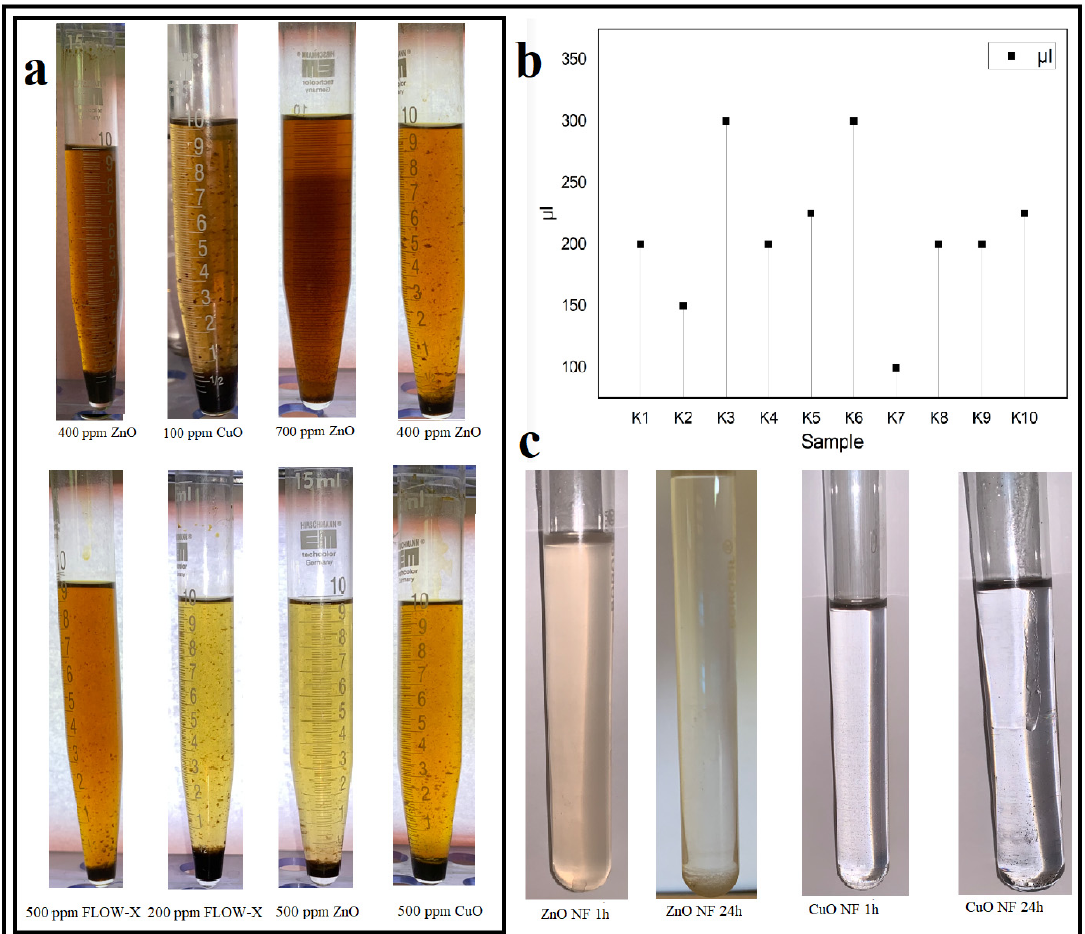
Figure 8. ( a ) ADT test results. ( b ) Blank Test concentration of crude to show 10% precipitation. ( c ) NF stability.